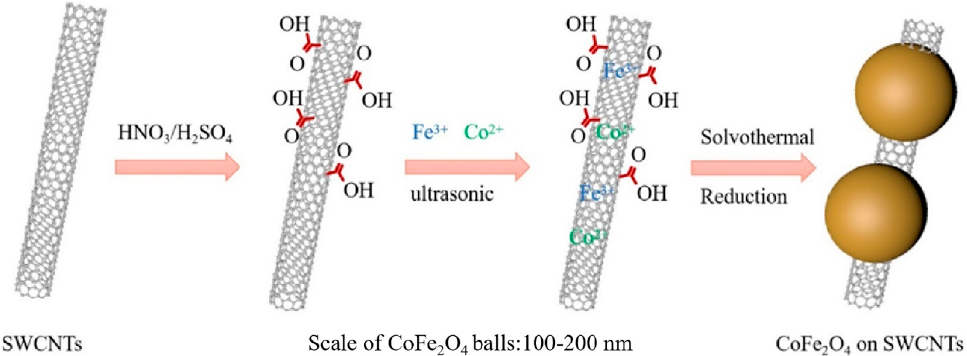
Figure 1. Schematic illustration of synthesis strategy for CoFe 2 O 4 /SWCNTs composites.